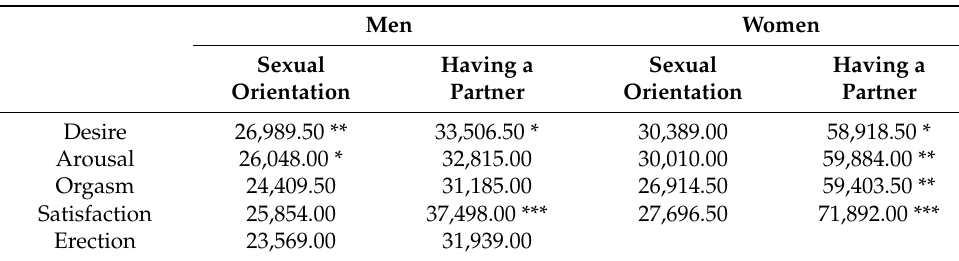
Table 3. Mann-Whitney U test for associations between sociodemographic characteristics and dimensions of sexual functioning.